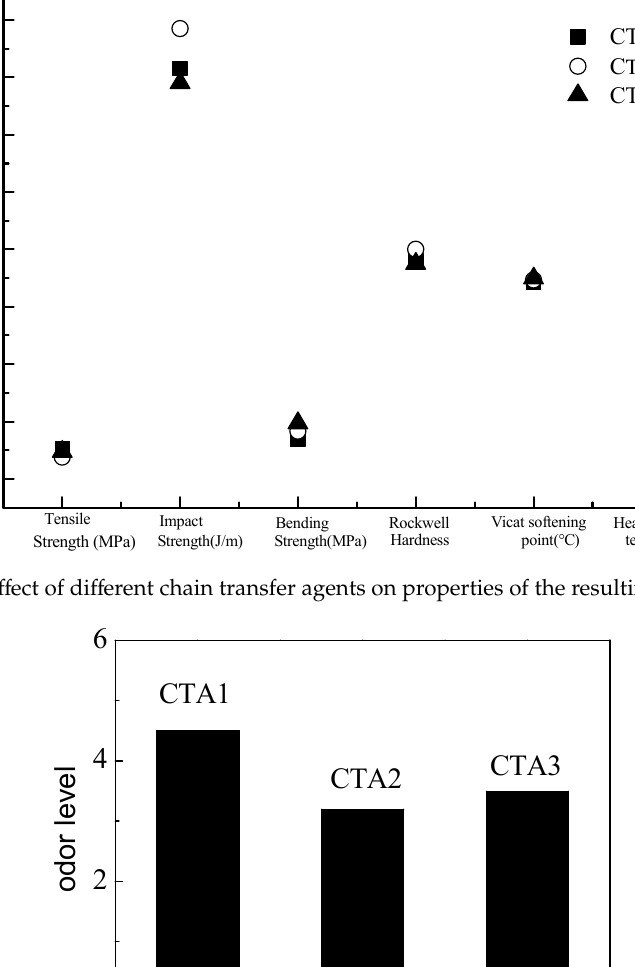
Figure 4. E ff ect of di ff erent chain transfer agents on the odor level of the resulting ABS Figure 4. Effect of different chain transfer agents on the odor level of the resulting ABS resins.